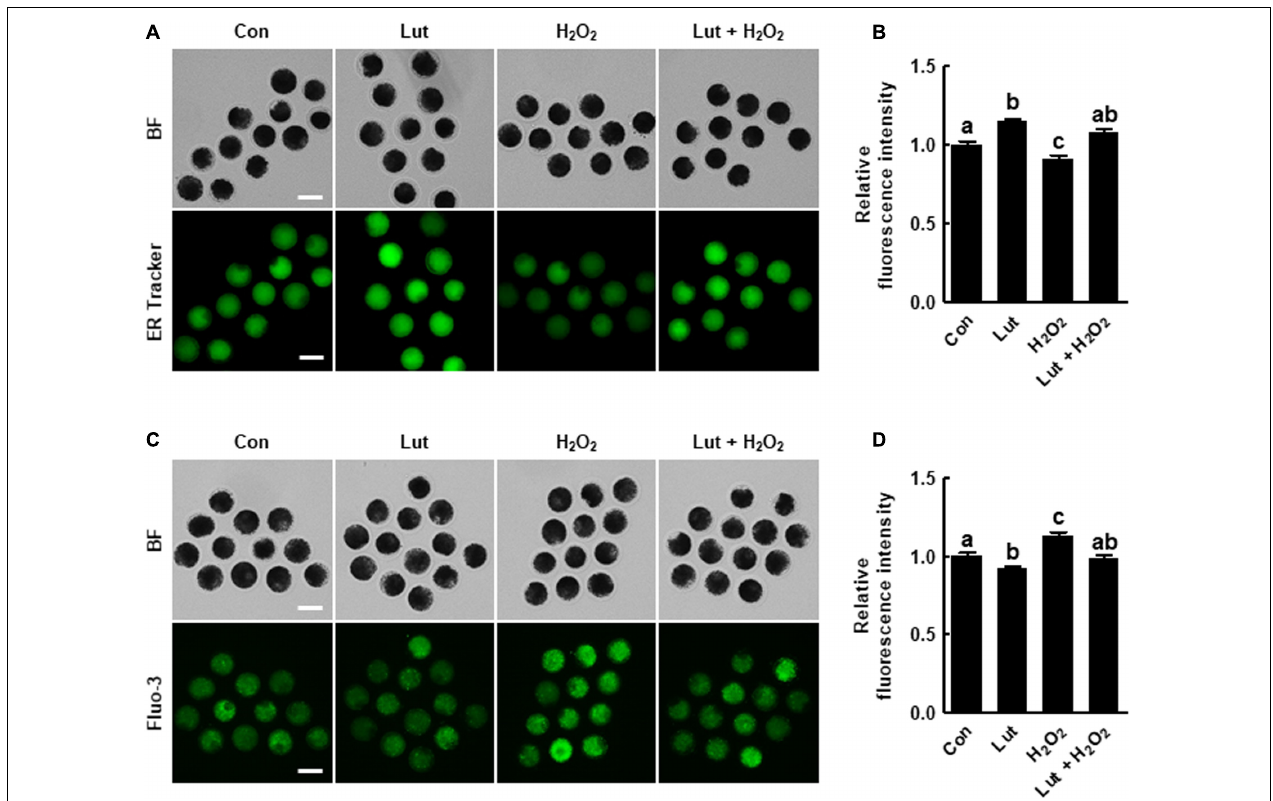
FIGURE 4 | Effects of Lut on endoplasmic reticulum (ER) defects induced by H 2 O 2 . (A) Representative images of porcine oocytes stained with ER Tracker and (B) relative fluorescence intensities in the indicated groups (Con, n = 40; Lut, n = 40; H 2 O 2 , n = 40; Lut + H 2 O 2 , n = 40). Scale bar = 100 µ m. (C) Representative fluorescent images and (D) relative fluorescence intensities representing intracellular calcium levels in oocytes stained with Fluo-3 in the indicated groups (Con, n = 38; Lut, n = 38; H 2 O 2 , n = 38; Lut + H 2 O 2 , n = 38). Scale bar = 100 µ m. The data are from at least three independent experiments, and the different superscript letters represent the significant difference ( p <